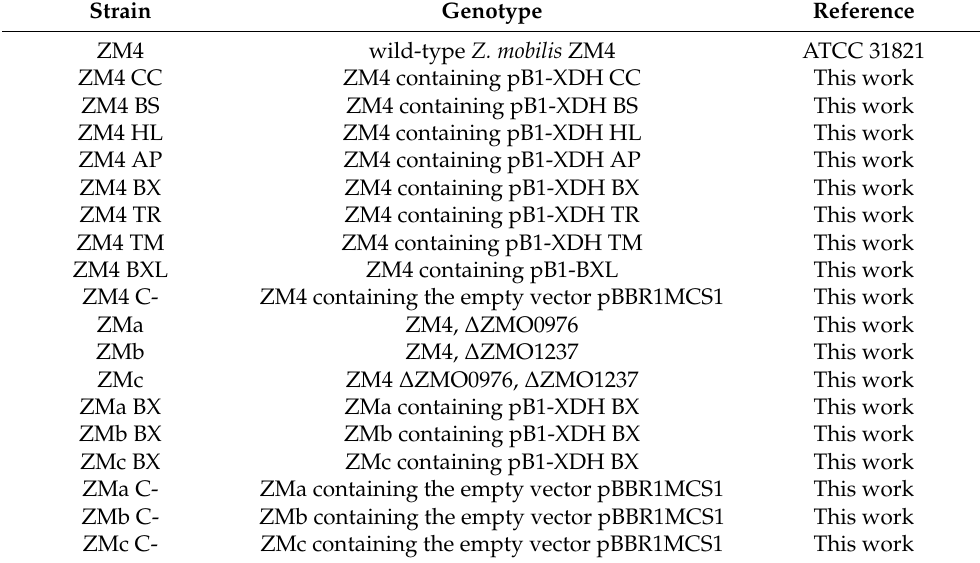
Table 1. Z. mobilis strains used in this